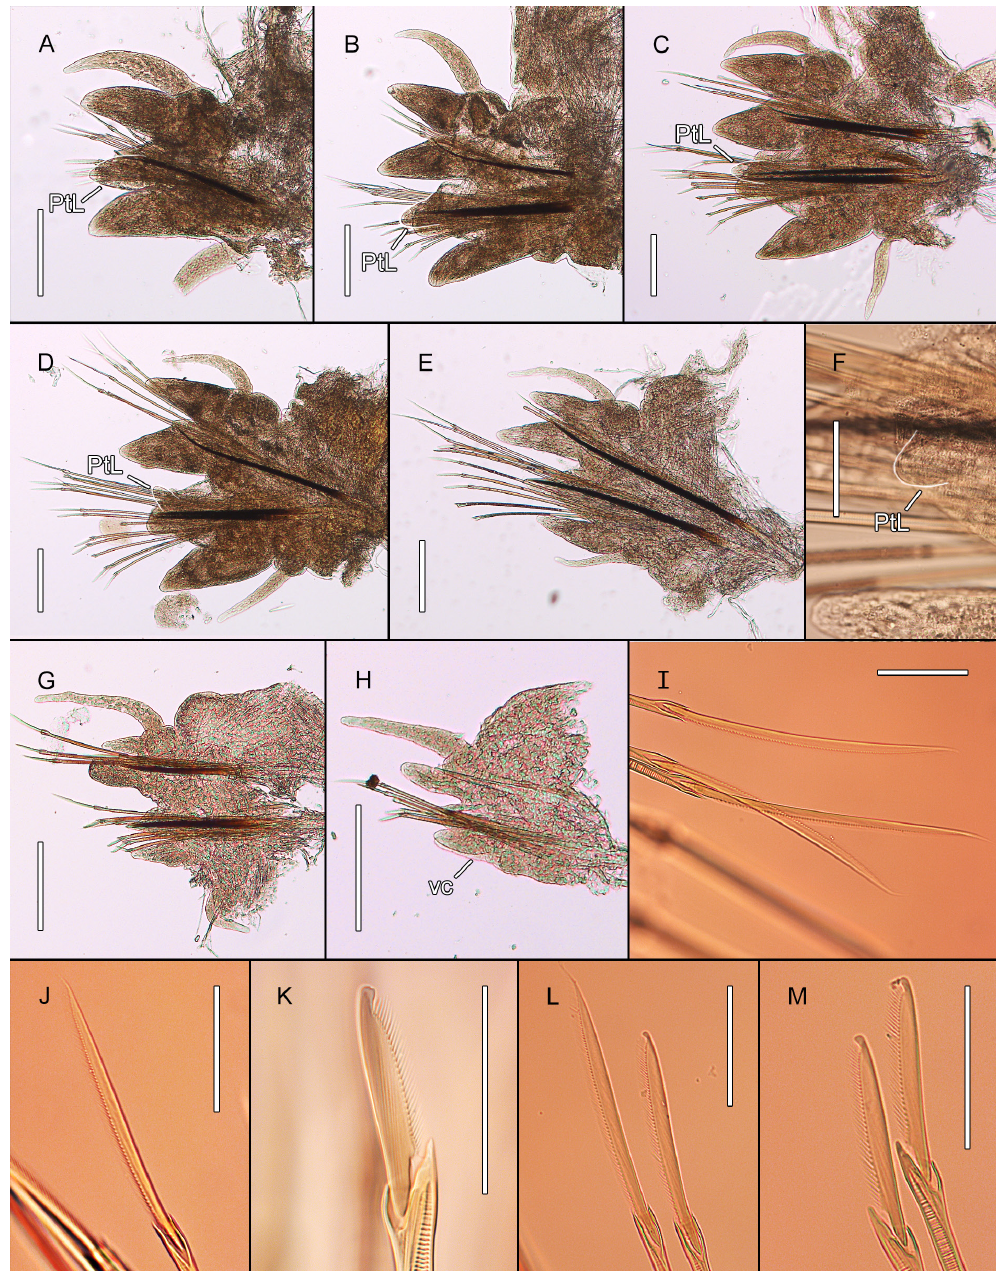
Fig. 3. Neanthes goodayi sp. nov., holotype (NHM_739). A . Chaetiger 1, posterior view. B . Chaetiger 3, posterior view. C . Chaetiger 6, posterior view. D . Chaetiger 20, posterior view. E . Chaetiger 29, posterior view. F . Chaetiger 29, posterior view, detail of neuracicular postchaetal lobe. G . Chaetiger 40, posterior view. H . Chaetiger 46, posterior view. I . Notochaetae, detail of homogomph spinigers, chaetiger 20. J . Supraciular neurochaetae, detail of homogomph spiniger, chaetiger 3. K . Supracicular neurochaetae, detail of heterogomph falciger, chaetiger 10. L . Subacicular neurochaetae, detail of homogomph spiniger (left) and homogomph falciger (right), chaetiger 20. M . Subacicular neurochaetae, detail of heterogomph falcigers, chaetiger 20. Abbreviations: PtL = postchaetal lobe; VC = ventral cirrus. Postchaetal lobe in A–D, F outlined with a fine white line. Parapodia in C, E–H dissected from left side of specimen; parapodia in A–B, D dissected from right side of specimen, with images laterally inverted follow direction of other plates. Scale bars: A–E, G–H = 200 µm; F, I–M = 50 172